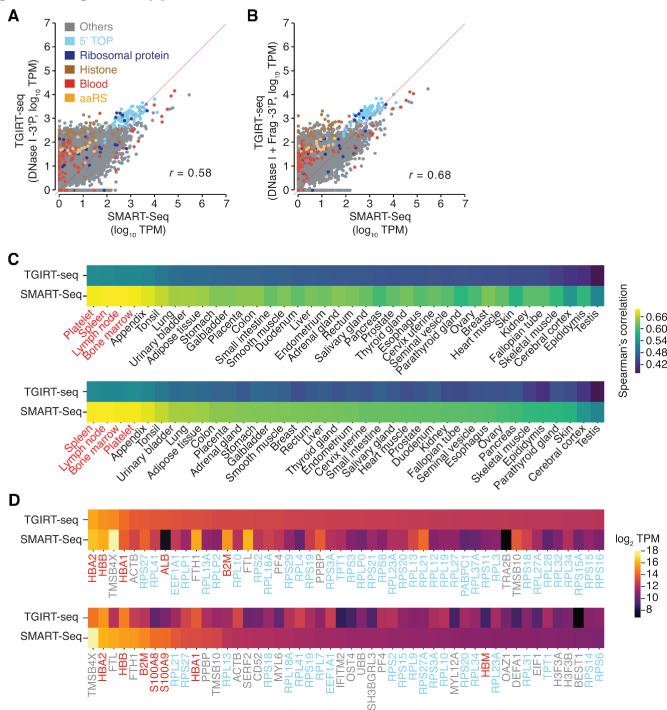
Additional scatter plots and heat maps comparing protein-coding gene transcripts detected in DNase I-treated plasma RNA by TGIRT-seq and SMART-Seq.(A, B) Scatter plots comparing the relative abundances of protein-coding gene transcripts detected in DNase I-treated plasma RNA in combined SMART-Seq datasets (n = 4) with those in combined TGIRT-seq datasets for DNase I-treated plasma RNA with 3'-phosphate removal (n = 3) or with chemical fragmentation followed by 3'-phosphate removal (n = 4), respectively. Data were processed as described for Figure 3A and B. (C) Heat maps comparing protein-coding gene transcripts detected by TGIRT-seq or SMART-Seq to primary tissue transcriptomic data obtained from the Human Protein Atlas (Uhlén et al., 2015) and platelet transcriptomic data obtained from Campbell et al., 2018. Primary tissues are ranked in descending order by Spearman correlation values from combined TGIRT-seq (top) or SMART-Seq (bottom) datasets. The names of blood-related tissues are in red. (D) Heat map of log2 TPM values for the top 50 most abundant protein-coding gene transcripts detected by TGIRT-seq (top panel) and SMART-Seq (bottom panel). The transcripts are shown in descending order of TPM values quantified by Kallisto, with the gene names color-coded as indicated in panel A.